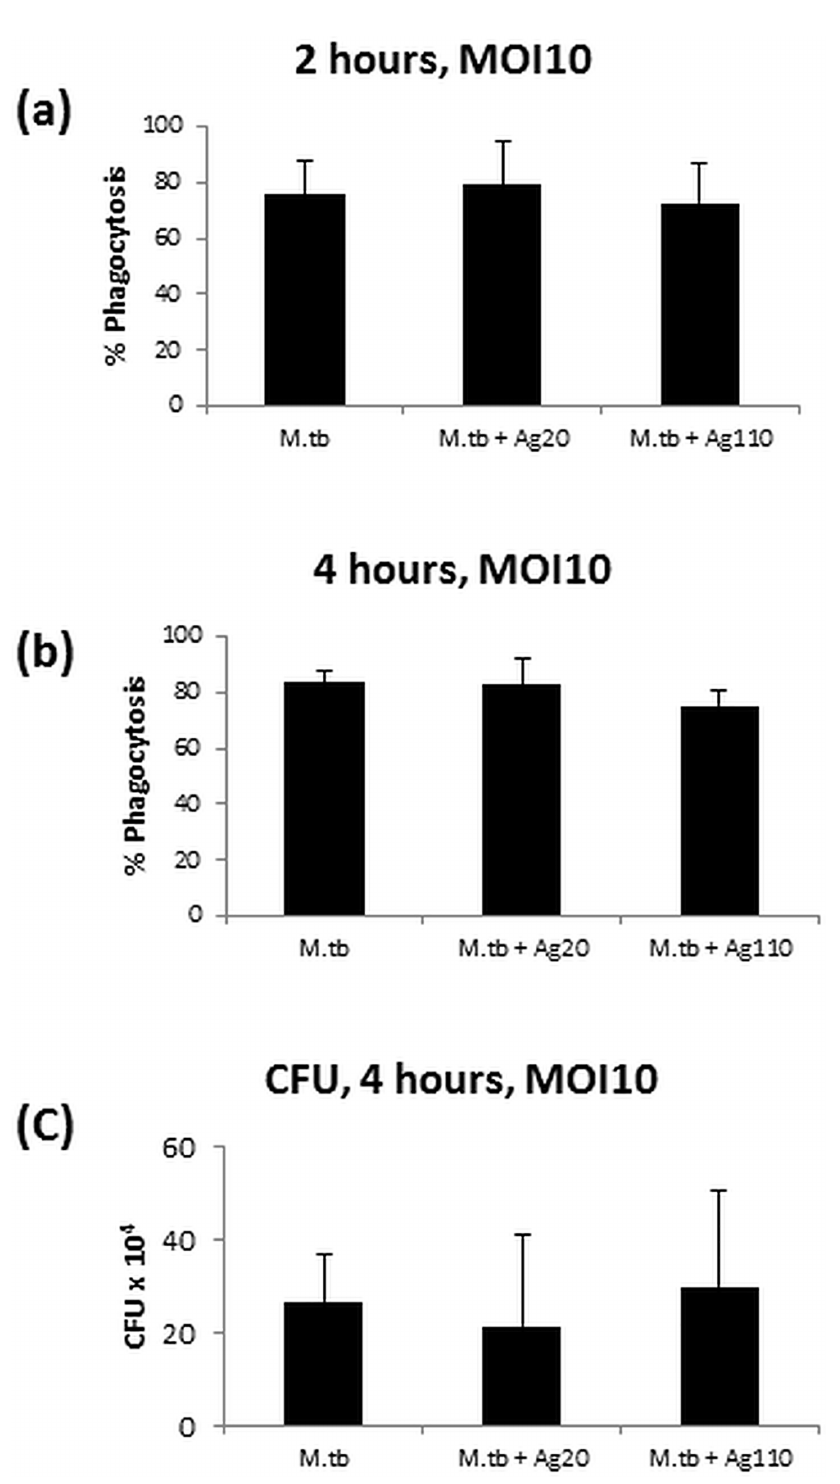
Fig 8. Effect of AgNP on the internalization of M . tb by MDM. MDM were infected with M . tb at MOI 10 in the absence or presence of 10 μ g/mL of AgNP and the percentage of MDM with internalized M . tb determined after 2 (panel a ) and 4 (panel b ) hours of infection. A total of 300 MDM was examined in each experimental condition as described in Materials and Methods. Results are expressed as mean percentages of MDM with internalized M . tb ± standard deviations from four independent experiments. To assess the number